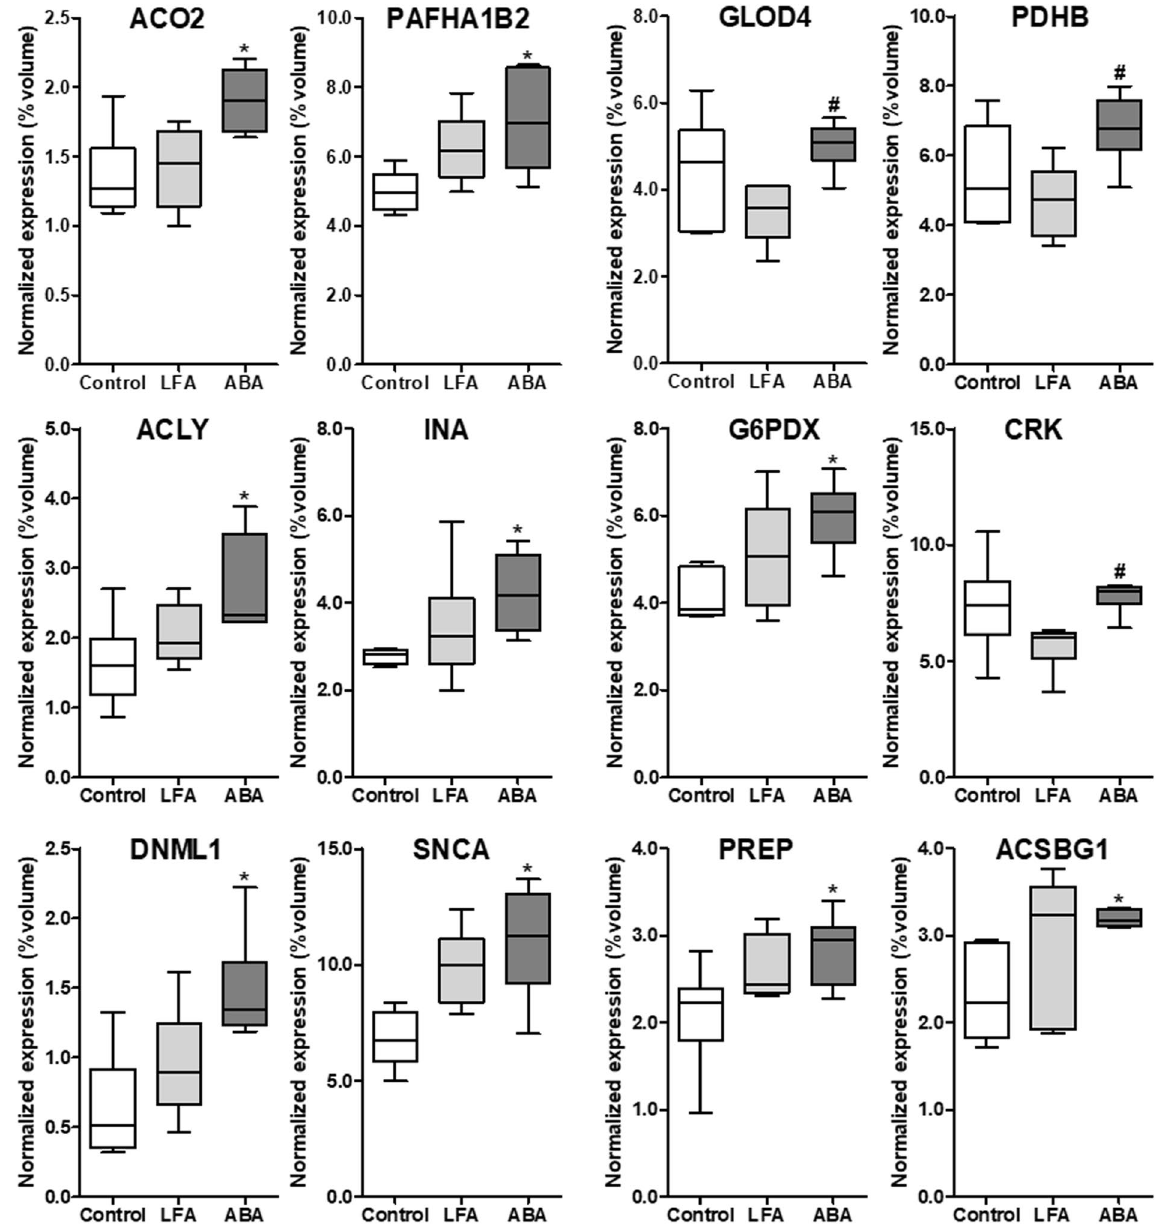
Figure 2. Hypothalamic proteins differentially expressed at day 10. Twelve differently modulated proteins were identified at d10 (n = 6/group). * p < 0.05 vs Control. # p < 0.05 vs LFA. ACO2: Aconitate hydratase, mitochondrial precursor; PAFAH1B2: Platelet-activating factor acetylhydrolase IB subunit beta; GLOD4: Glyoxalase domain-containing protein 4; PDHB: Pyruvate dehydrogenase E1 component subunit beta, mitochondrial; ACLY: ATP-citrate synthase; INA: Alpha-internexin; G6PDX: Glucose-6-phosphate 1-dehydrogenase X; CRK: Adapter molecule Crk; DNM1L: Dynamin-1-like protein; SNCA: Alpha-synuclein; PREP: Prolyl endopeptidase; ACSBG1: Long chain fatty acid coA